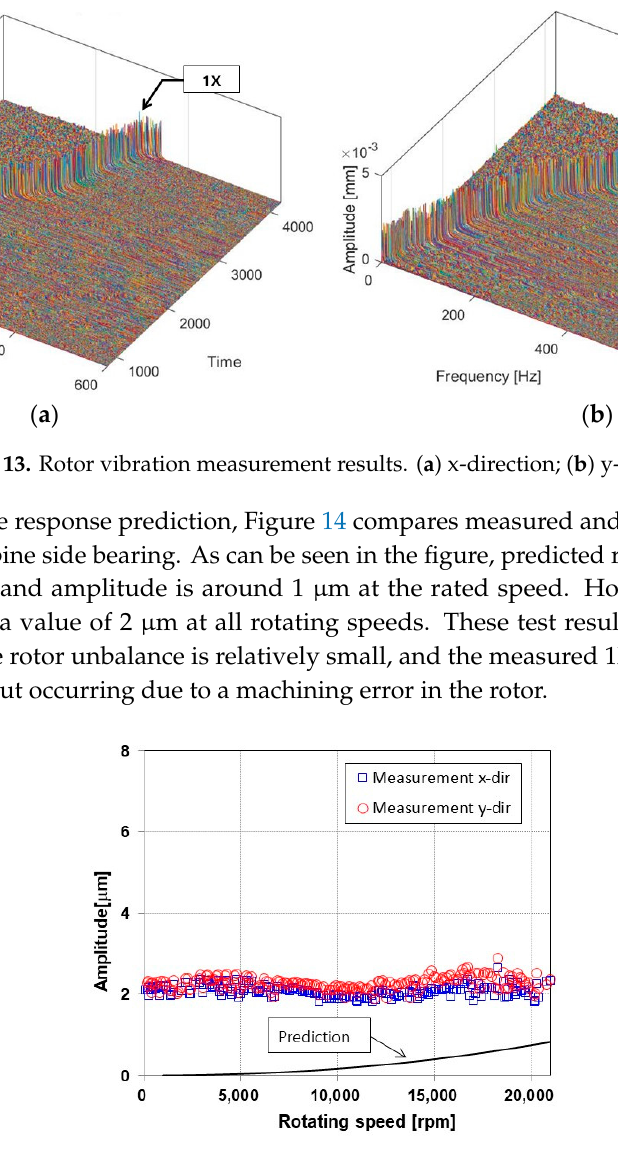
( b ) Figure 12. Test loop for pump-drive turbine. ( a ) Test loop for supercritical CO 2 cycle; ( b ) Pump-drive turbine module. In the test, high-temperature, high-pressure CO 2 (84 bar, 136 °C) generated through a pump and a heater (boiler) was supplied to the drive turbine; the flow rate was adjusted through a valve to